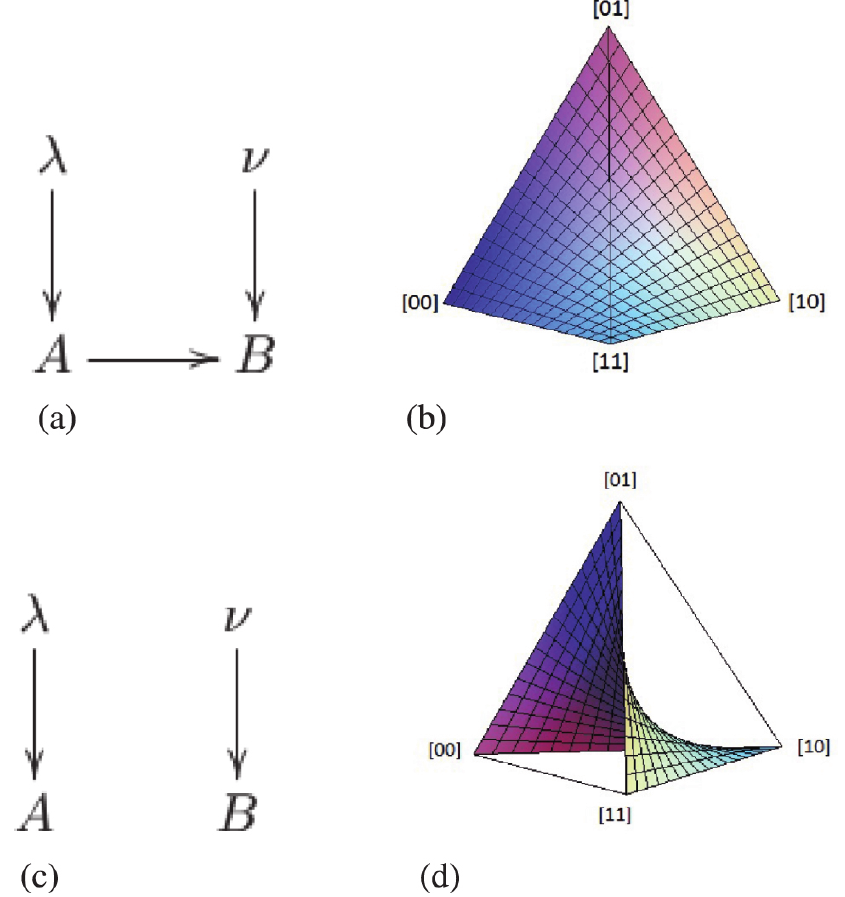
Figure 2: (a) DAG for causal model defined by u = u and u = u ⊕ u . (b) Joint distributions that can be generated